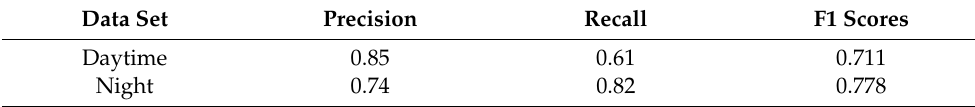
Figure 21. Target tracking of different scales in actual system navigation. Table 4. Daytime and night data set evaluation.